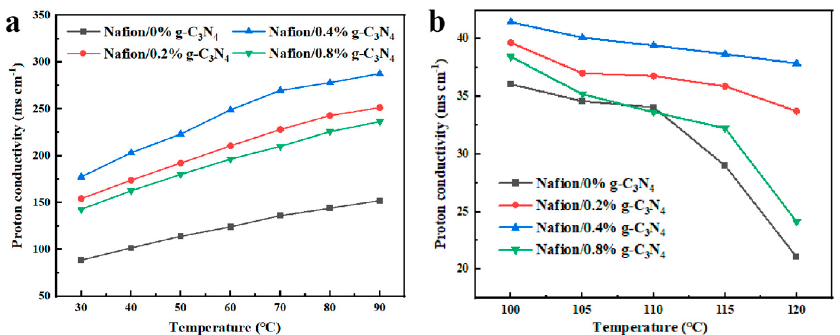
Figure 9. Proton conductivity of the Nafion/g − C 3 N 4 modified membranes at ( a ) 30–90 °C and ( b ) 100–120 °C.